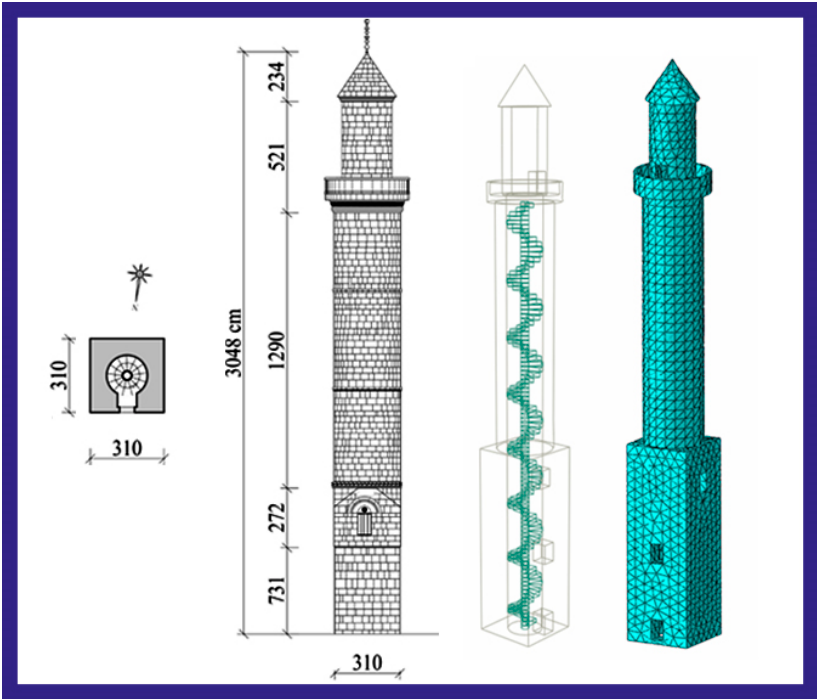
Figure 19. Bitlis Ulu Mosque’s minaret and 3D minaret models developed by the software program. Table 9. Modal analysis results of the minaret model.